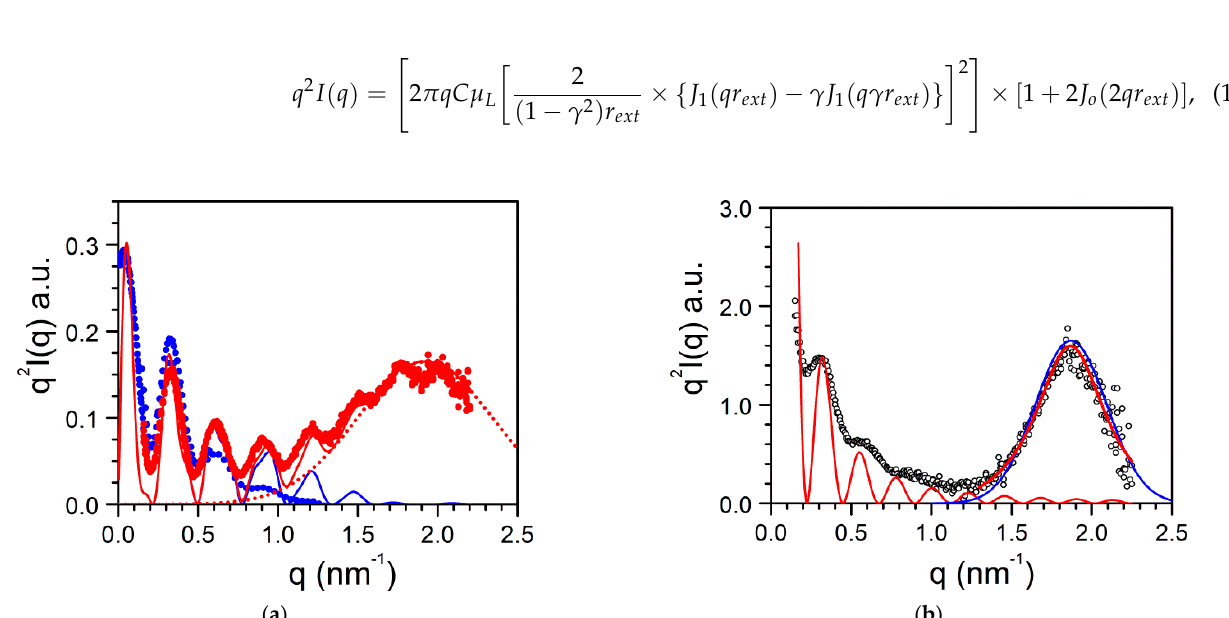
Figure 12. Scattering patterns plotted by means of a Kratky plot ( q 2 I ( q ) vs. q ): ( a ) Scattering pattern for BHPB-10/ trans -decahydronaphthalene systems plotted by means of a Kratky plot ( q 2 I ( q ) vs. q ) for ( • ) SAXS data; ( • ) SANS data; blue line fit with Equation (17); dotted line with Equation (19), red line corresponds to relations 17 + 19. ( b ) SAXS data for BHPB-10/ cis -decahydronaphthalene systems; red line fit with Equation (20); blue line fit of the peak with relation 16 blue line with relation 19 (see text for details). [33].